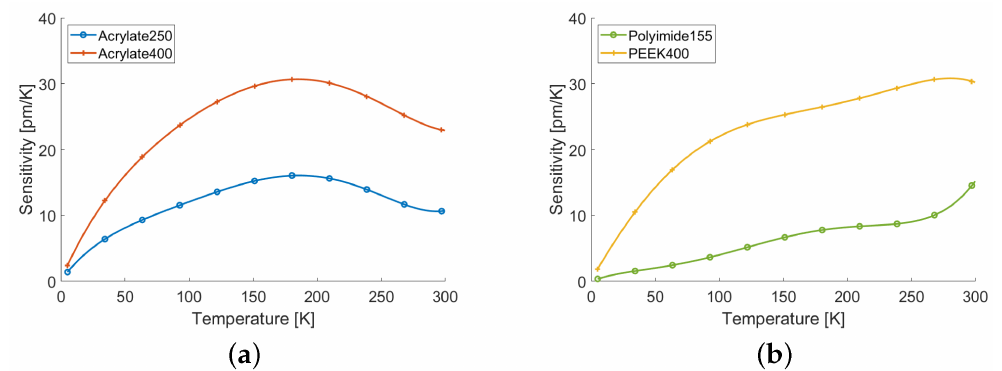
Figure 5. Temperature sensitivities in terms of the Rayleigh wavelength shift of SMF28 fibers with coatings of different material and thickness. The names in the legends indicate the coating material and the total diameter in micrometers of the coated fiber (adapted from Ref.